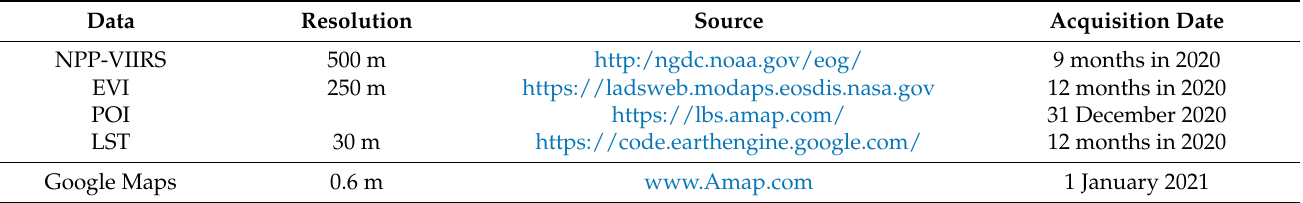
Table 1. Shows the data for the categories mentioned